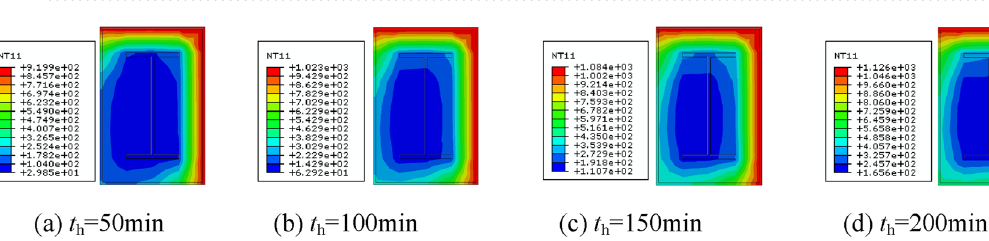
Figure 9. Cross-sectional temperature clouds at various stages of the fire on all two